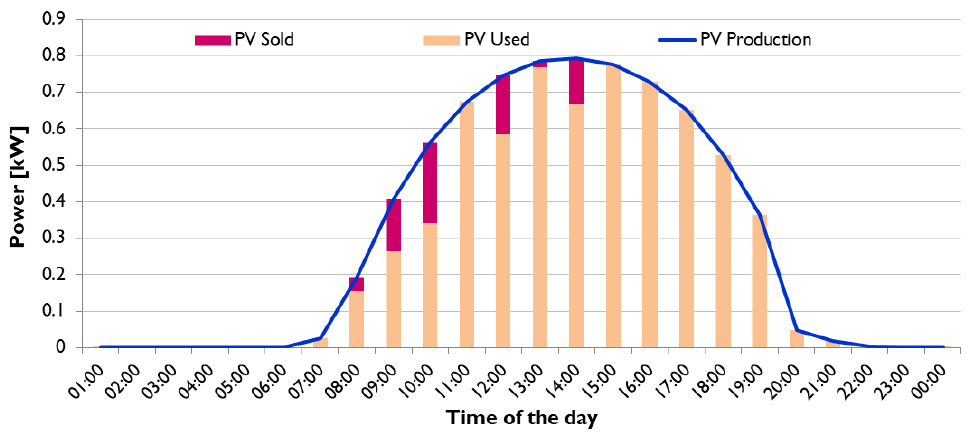
Figure 13. The PV system power decomposition for sample summer case.